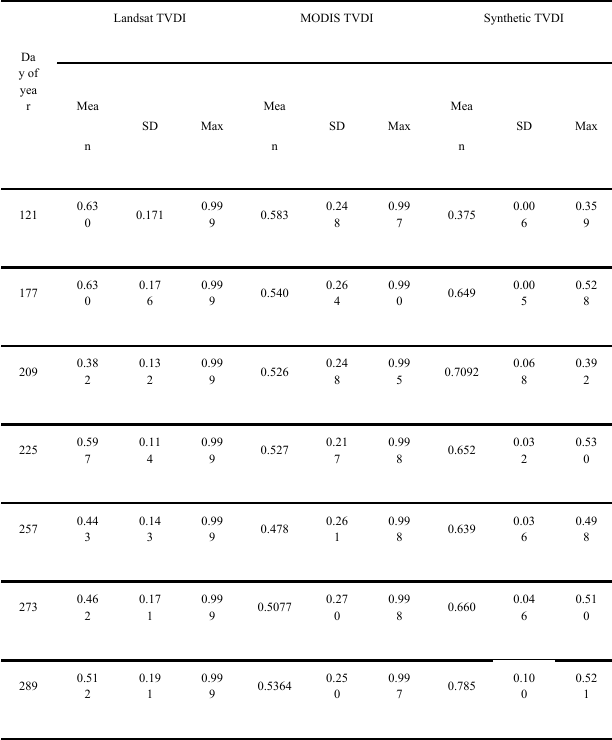
Table 1. The summary statistics: time series level mean values (Mean), standard deviation (SD) and maximum values of each image